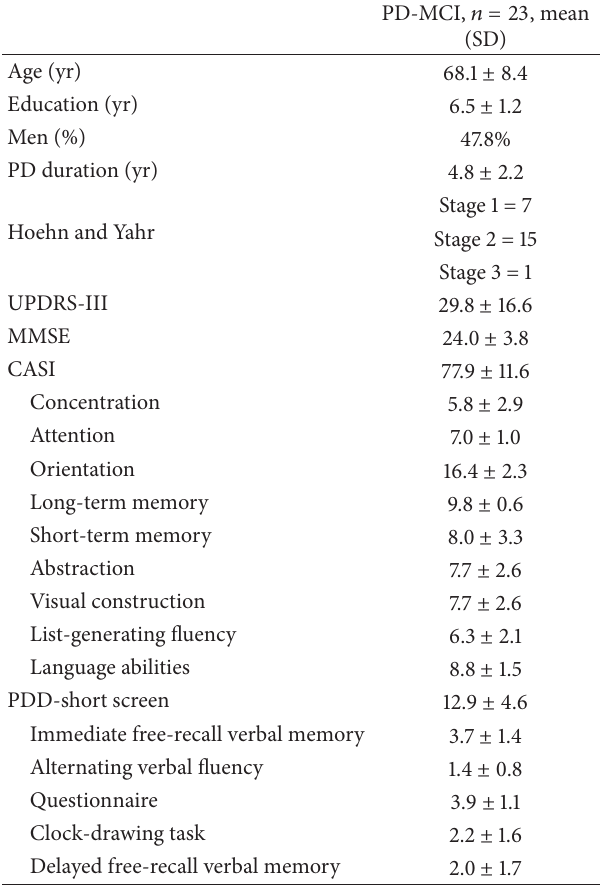
Table 1: Clinical and demographic characteristics of the PD-MCI patients.